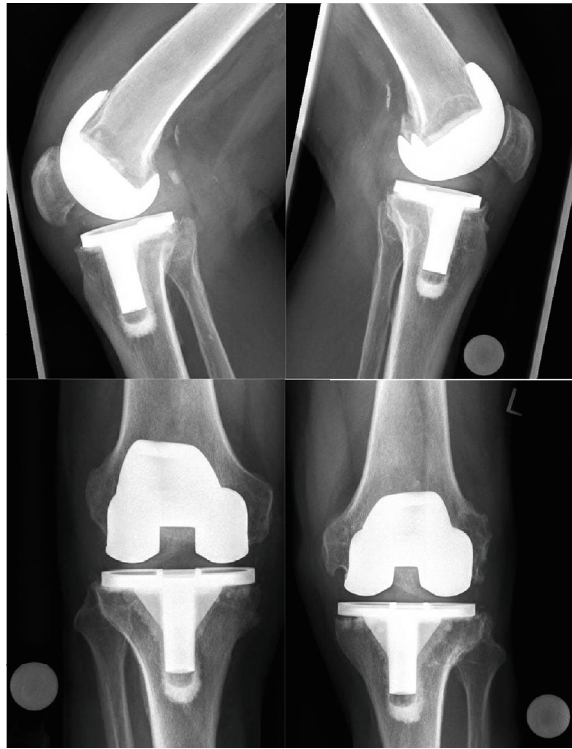
Figure 1: The preoperative diagnostics included radiographs of both knees in 2 planes.